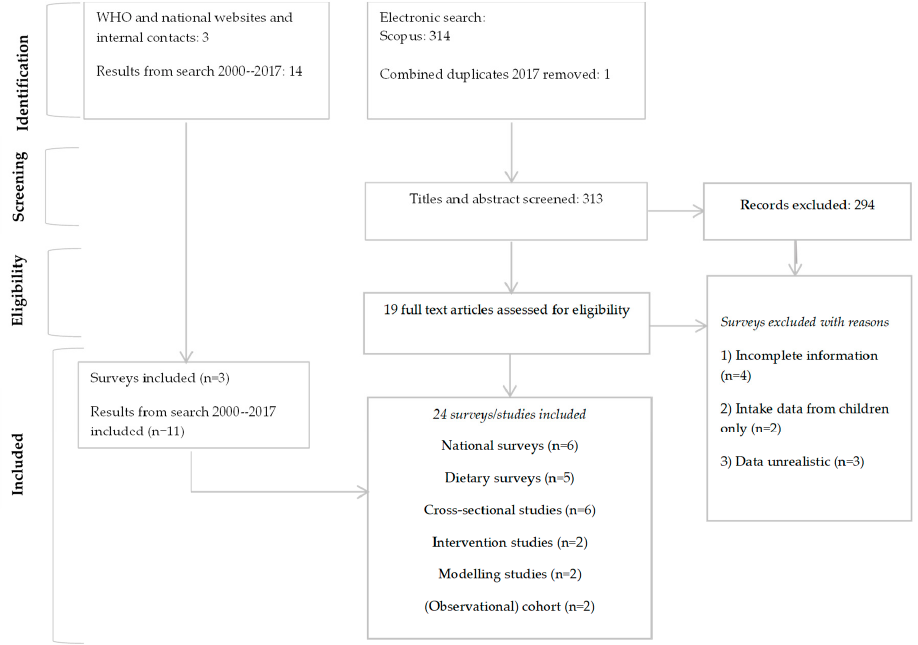
Figure 1. PRISMA flow diagram of the identification of literature for inclusion in this systematic search.